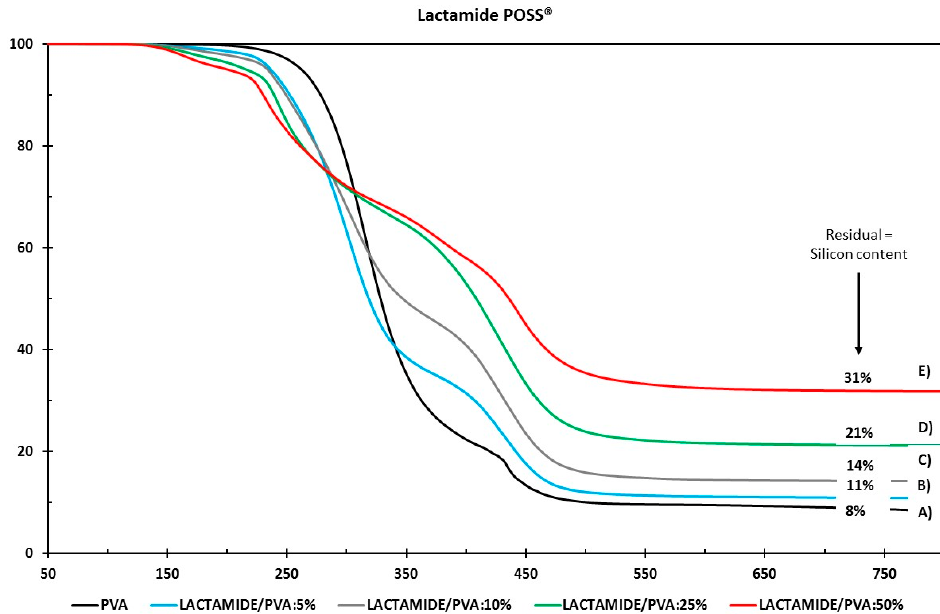
Figure 7. Thermogravimetric analysis of (A) PVA, Lactamide POSS ® /PVA: (B) 5%; (C) 10%; (D) 25%; (E) 50%.